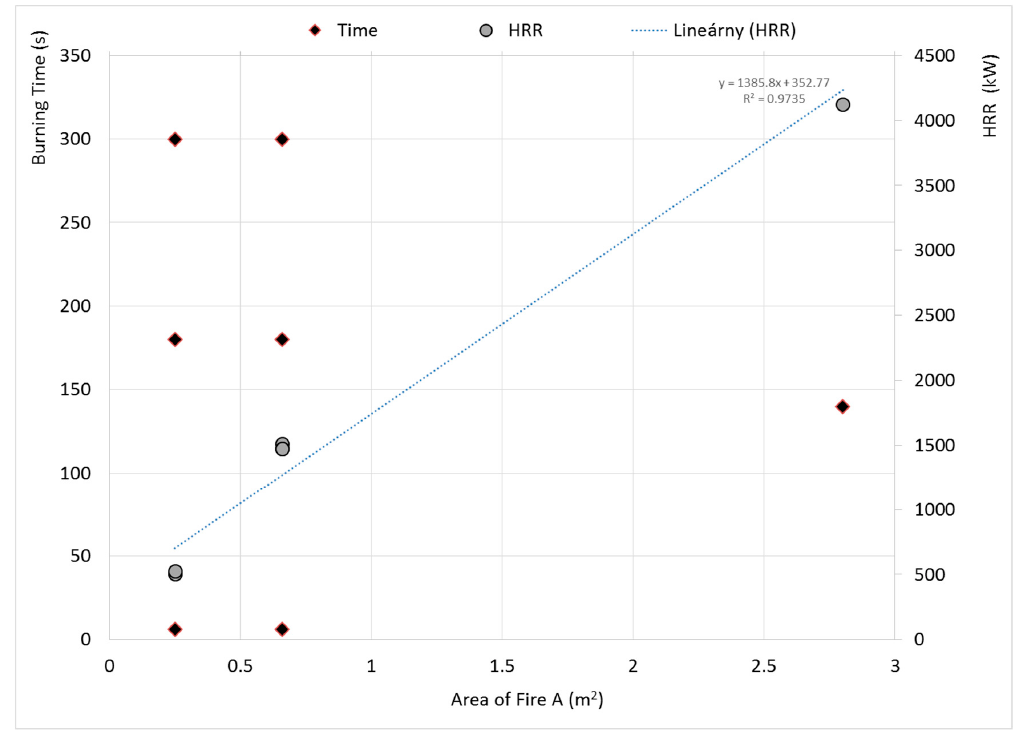
Figure 4. Relation between HRR from Area of Fire.